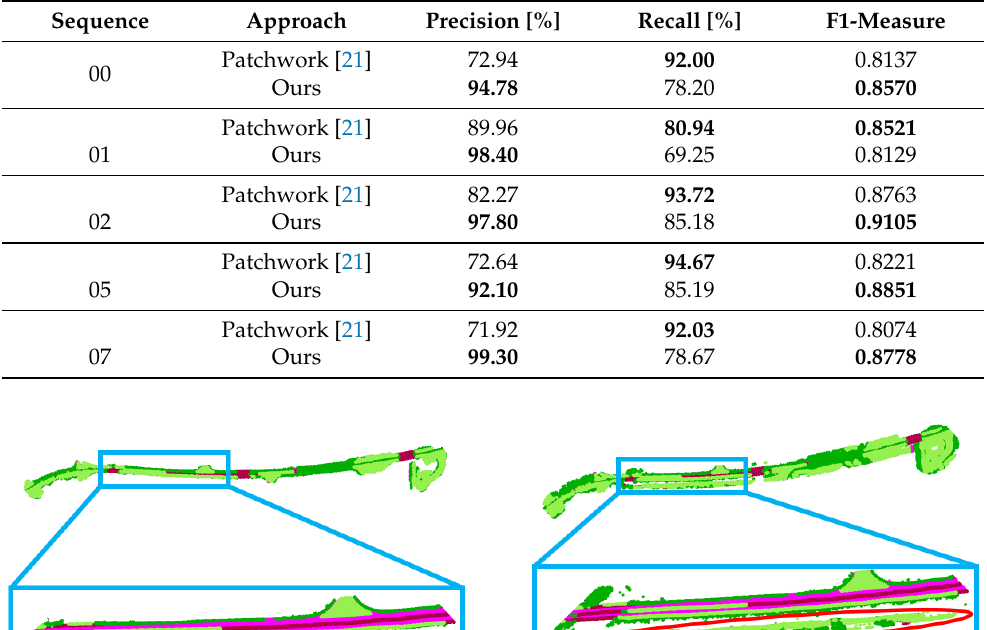
Table 1. Terrain modeling results on the SemanticKITTI dataset. The best results are colored in bold.